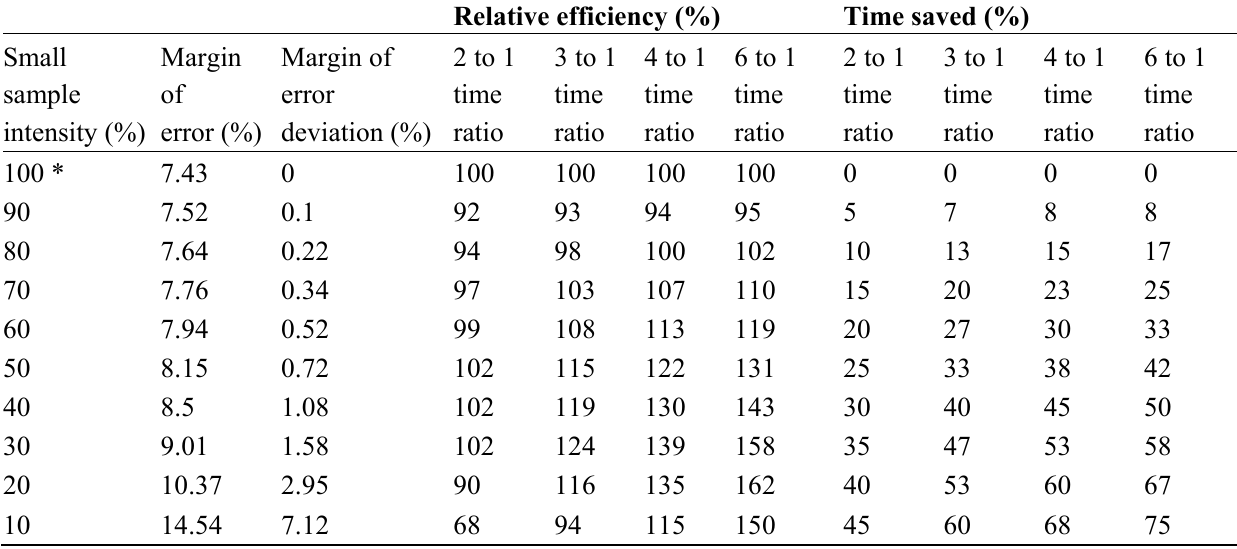
Table 2. Margin of error, deviation from original inventory margin of error, time saved, and relative efficiency for different levels of subsampling and four different small to large sample time requirement ratios in double sample biomass inventories.